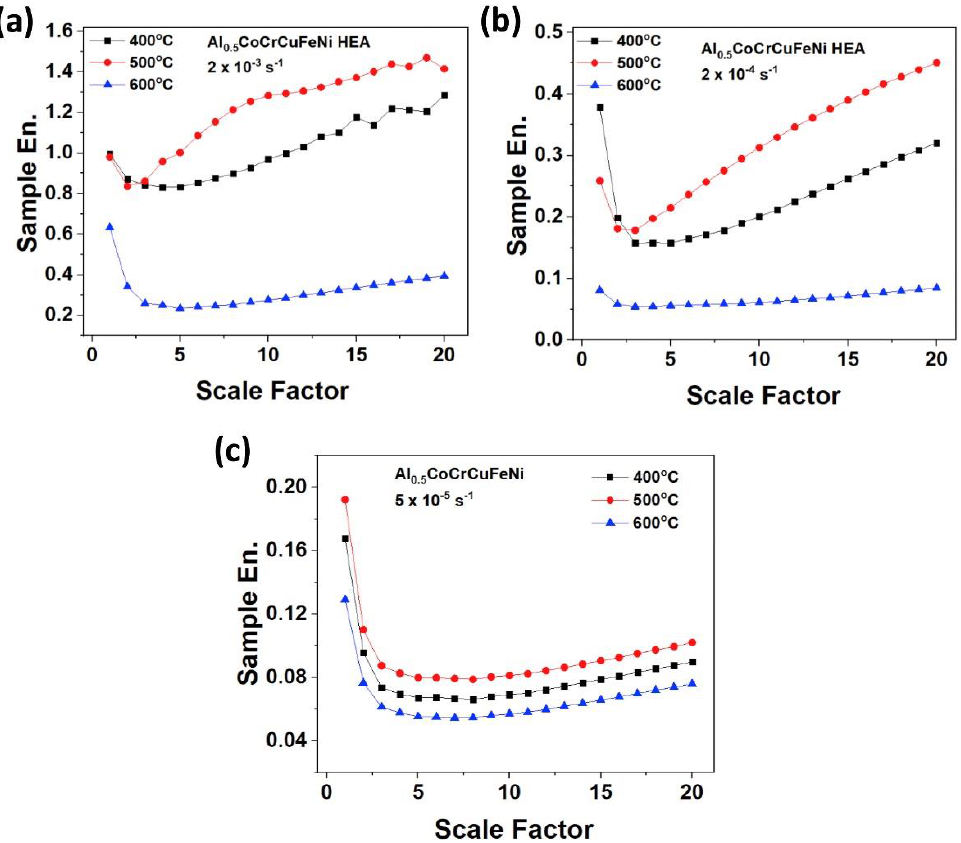
Figure 15. Sample entropy vs. scale factor for the Al 0.5 CoCrCuFeNi HEA samples tested at strain rates of ( a ) 2 × 10 −3 s −1 , ( b ) 2 × 10 −4 s −1 , and ( c ) 5 × 10 −5 s −1 and temperatures of 400–600 °C, where the sample entropy was plotted for scale factors ranging from 1 to 20 (reproduced from Reference [180] with permission).